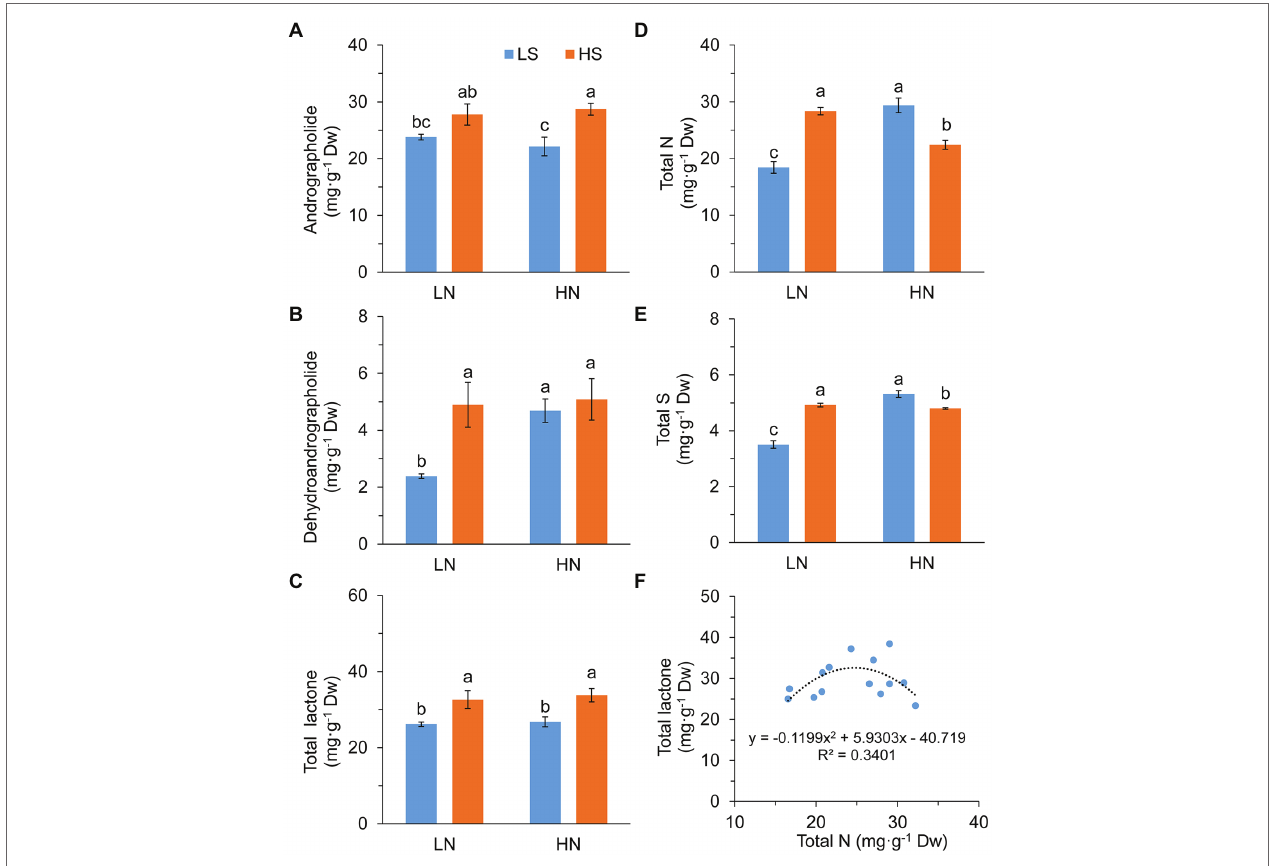
FIGURE 2 | Diterpene lactones, nitrogen, and sulfur concentration and the relationship between N and lactone in leaves of A. paniculata plants grown under different nitrogen and sulfur conditions. (A) Andrographolide concentration. (B) Dehydroandrographolide concentration. (C) Total lactone (andrographolide + dehydroandrographolide) concentration. (D) Total leaf N concentration. (E) Total leaf S concentration. (F) The relationship between total leaf N concentration and total lactone concentration. Data were presented as mean ± SE ( n = 4). Different letters on the bars indicate significant difference among treatments at p < 0.05 using the method of LSD . LN, low nitrogen; HN, high nitrogen; LS, low sulfur; HS, high